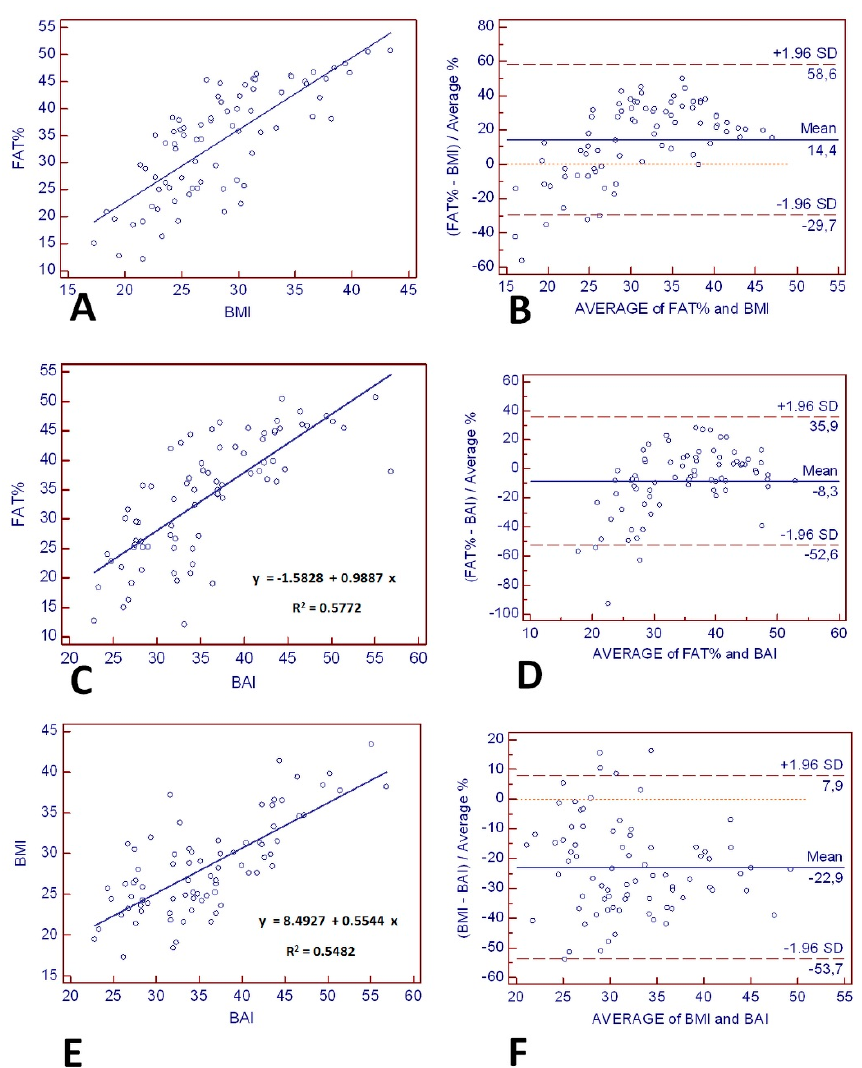
Figure 3. The line of regression for ( A ) bioelectrical impedance analysis (BImpA) (FAT%) and BMI, ( C ) BImpA (FAT%) and BAI, and ( E ) BMI and BAI is represented by the solid line, and the line of equality by the dotted line. The Bland–Altman Plot (right panels) provides an interval within which 95% of differences between derived from ( B ) BMI–BImpA (FAT%), ( D ) BAI–BImpA (FAT%), and ( F ) BMI–BAI. The thick black line represents the mean bias (mean of the differences), the dotted line (line of equality), and the two thin horizontal lines are drawn at the 95% confidence interval of limits of agreement (mean bias ± 2SD).